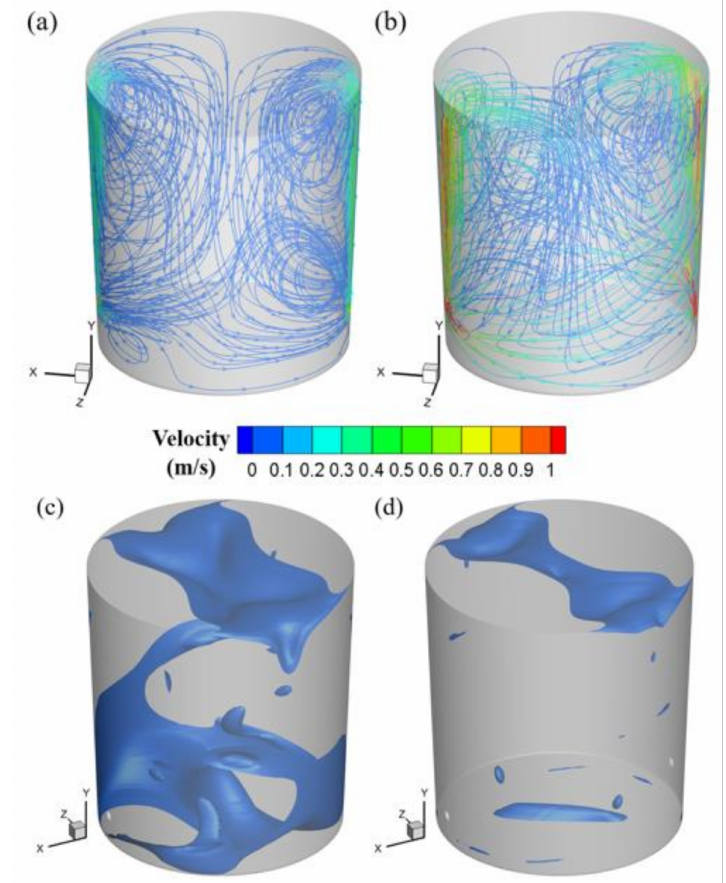
Figure 10. Flow parameters of water in model ladle with dual side plugs at 116 mm under different flow rates: ( a ) streamline of 0.6 m 3 /h; ( b ) streamline of 3.0 m 3 /h; ( c ) stagnant region of 0.6 m 3 /h; ( d ) stagnant region of 3.0 m 3